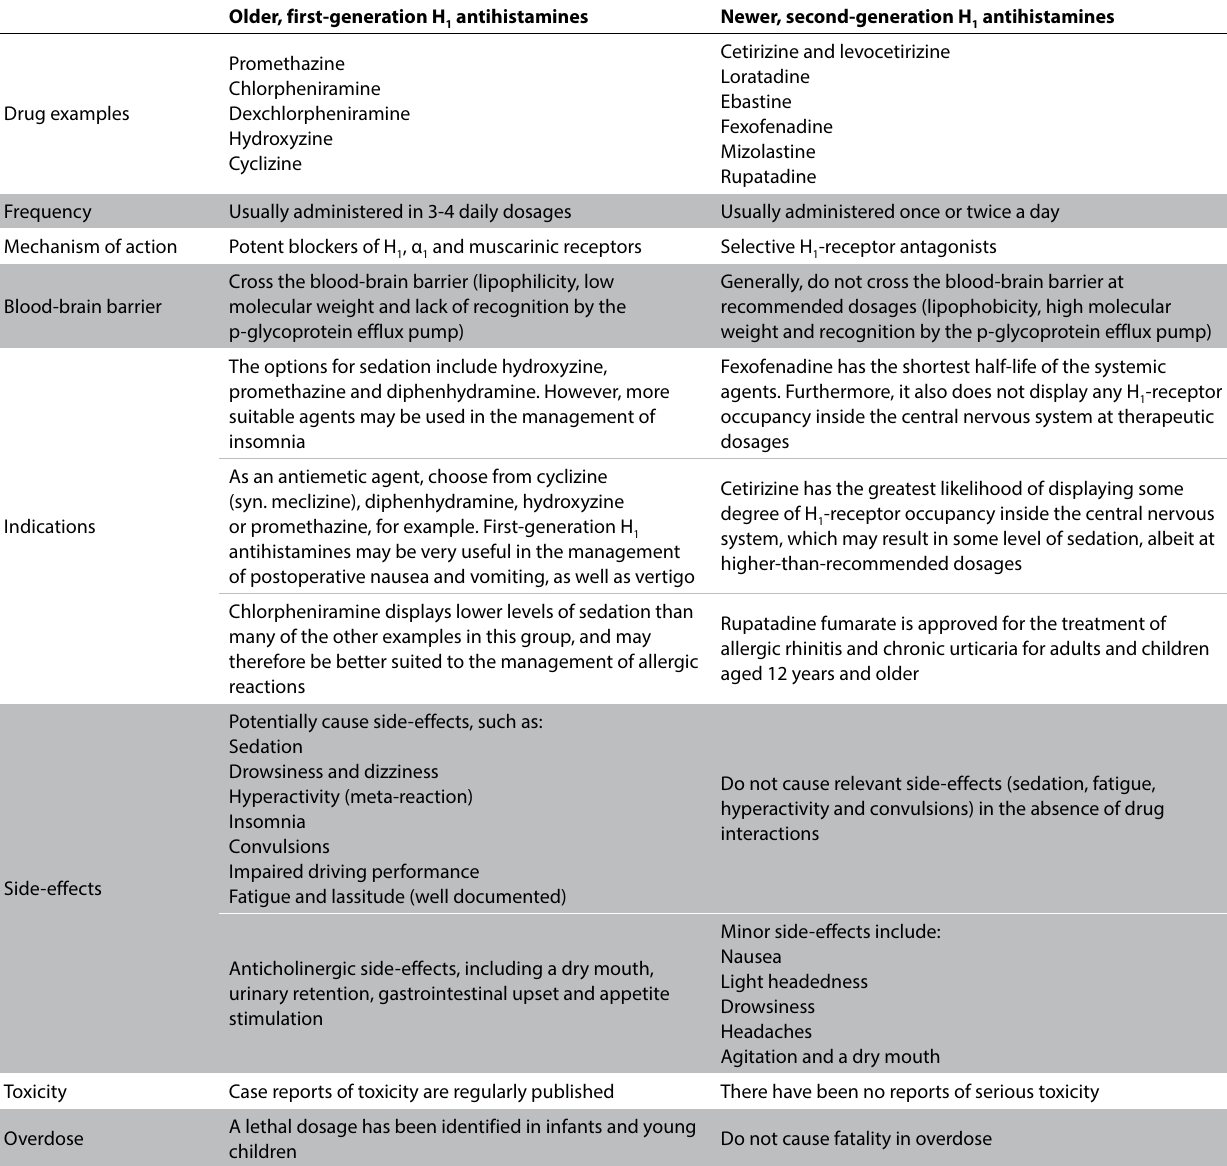
Table I: The differences between first- and second-generation histamine 1 antihistamines 35 Older, first-generation H 1